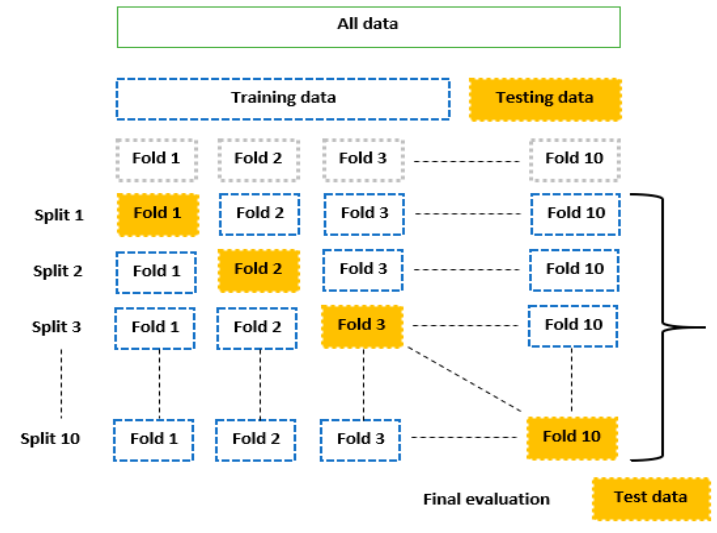
Figure 6. The k-fold technique that used in the study.